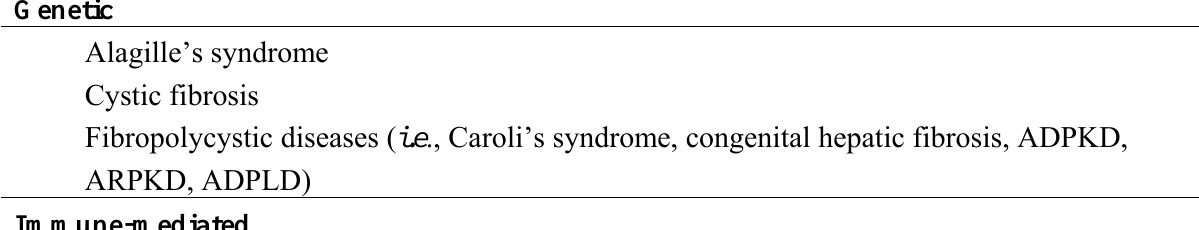
Table 1. Classification of